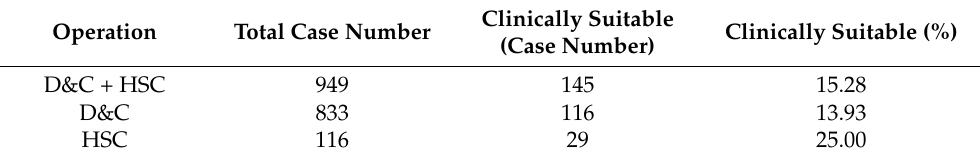
Table 8. Cases that were suitable by applying clinical selection and exclusion